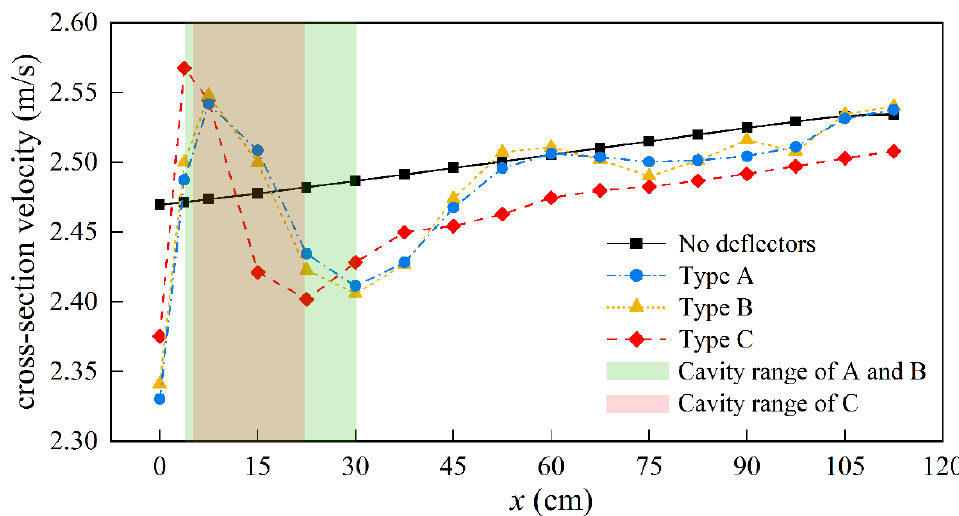
Figure 9. Streamwise development of the cross-sectional velocity along the flume with three different deflectors and without deflectors. The brown color indicates regions where the cavity range of C (pink) overlaps those of A and B (green).